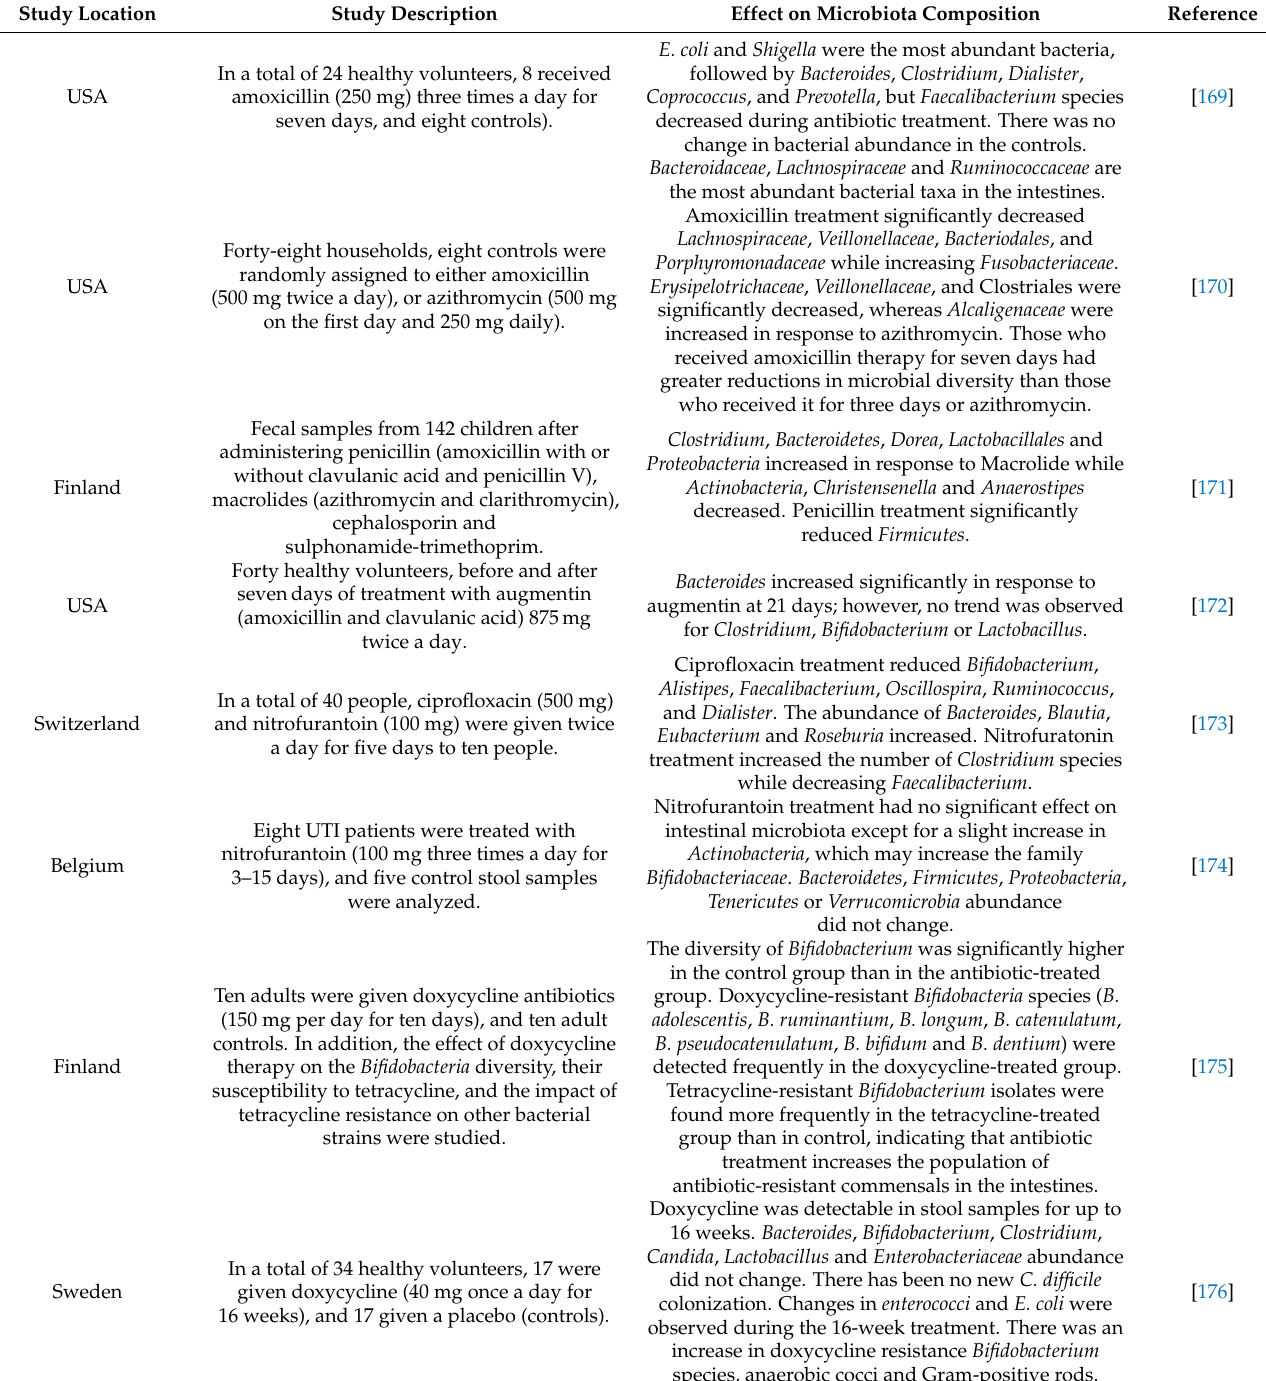
Table 1. Studies assessing the impact of antibiotic therapy on intestinal microbiota